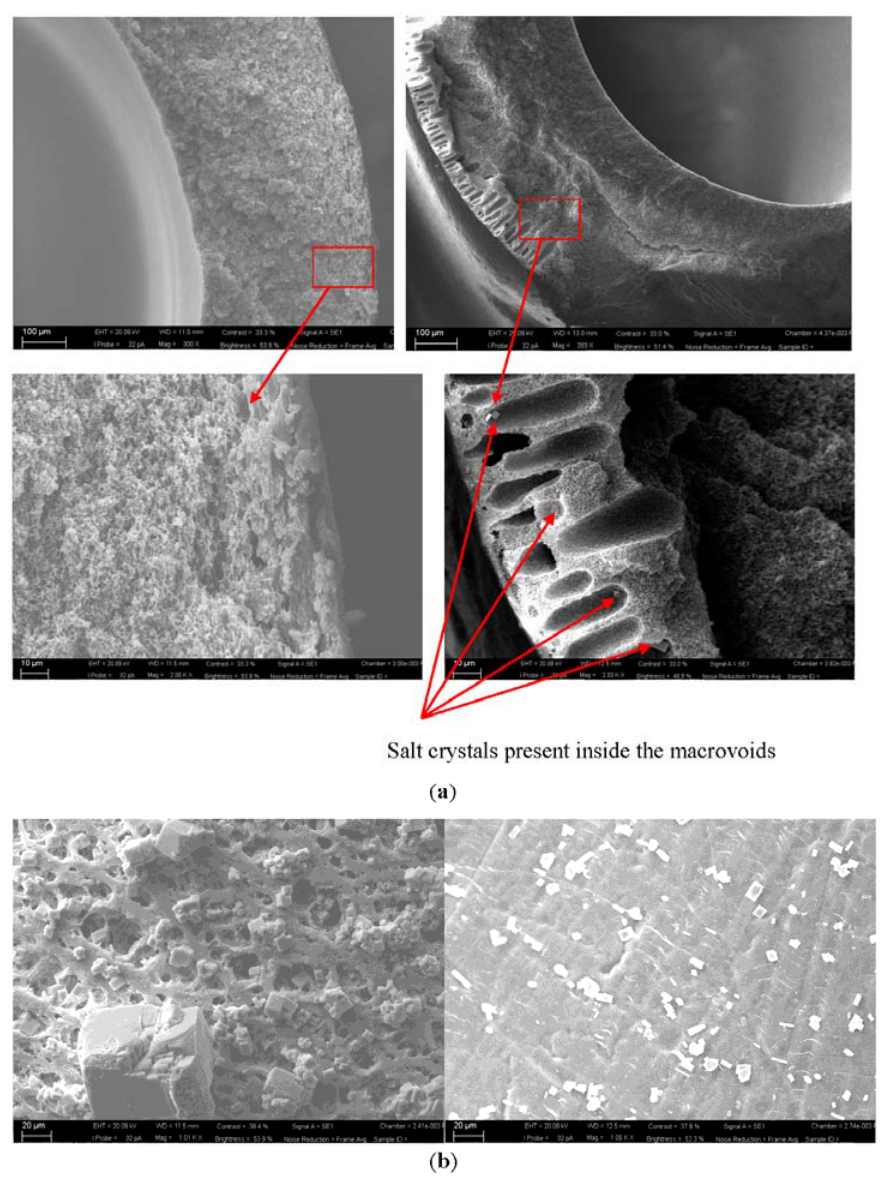
Figure 13. SEM images of PP ( left ) and PVDF ( right ) membranes used ( a ) Images of cross sections of used membrane; salt crystals present in PVDF membrane have been indicated with arrows ( b ) Surface images of the corresponding membranes, crystals within pores and at the surface are